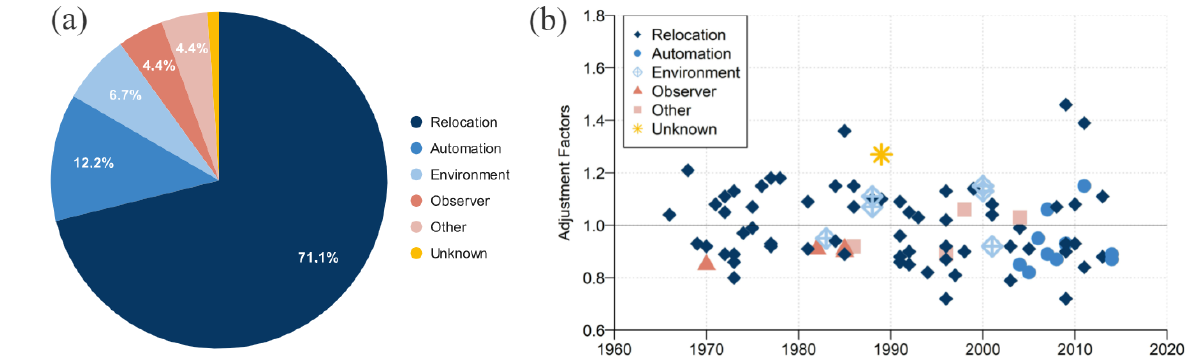
Figure 2. (a) Reasons for inhomogeneities in the Norwegian precipitation series. They include relocation of the rain gauge, automation of the station, environmental changes, change of observer, and other unknown reasons. (b) Annual adjustment factors for all the detected inhomogeneities plotted against time grouped by their